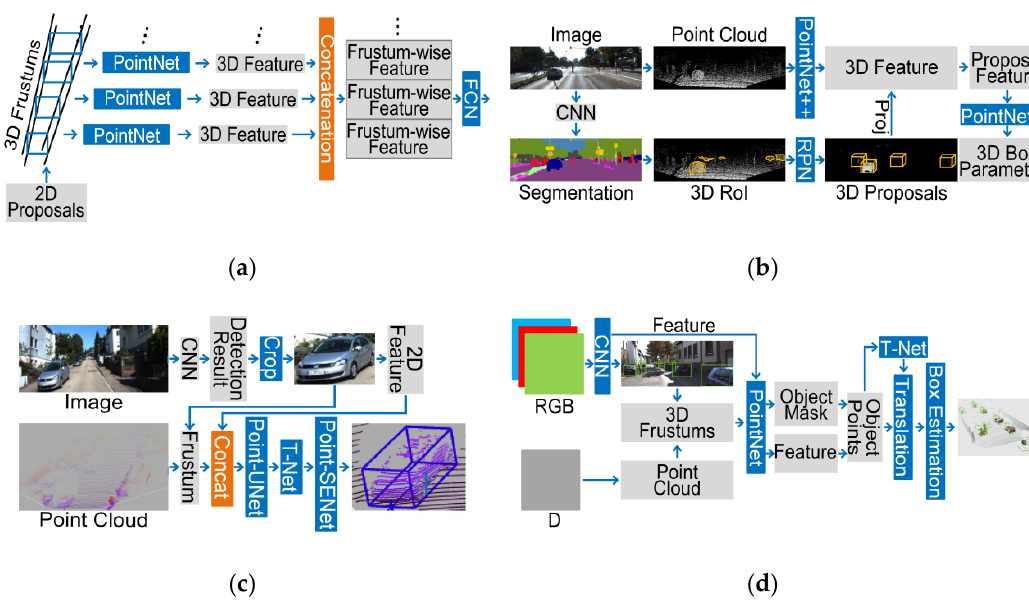
Figure 6. The representative detection methods using data–result-based fusion strategy. ( a ) Frustum PointNet; ( b ) IPOD; ( c ) SIFRNet; ( d ) Frustum ConvNet.